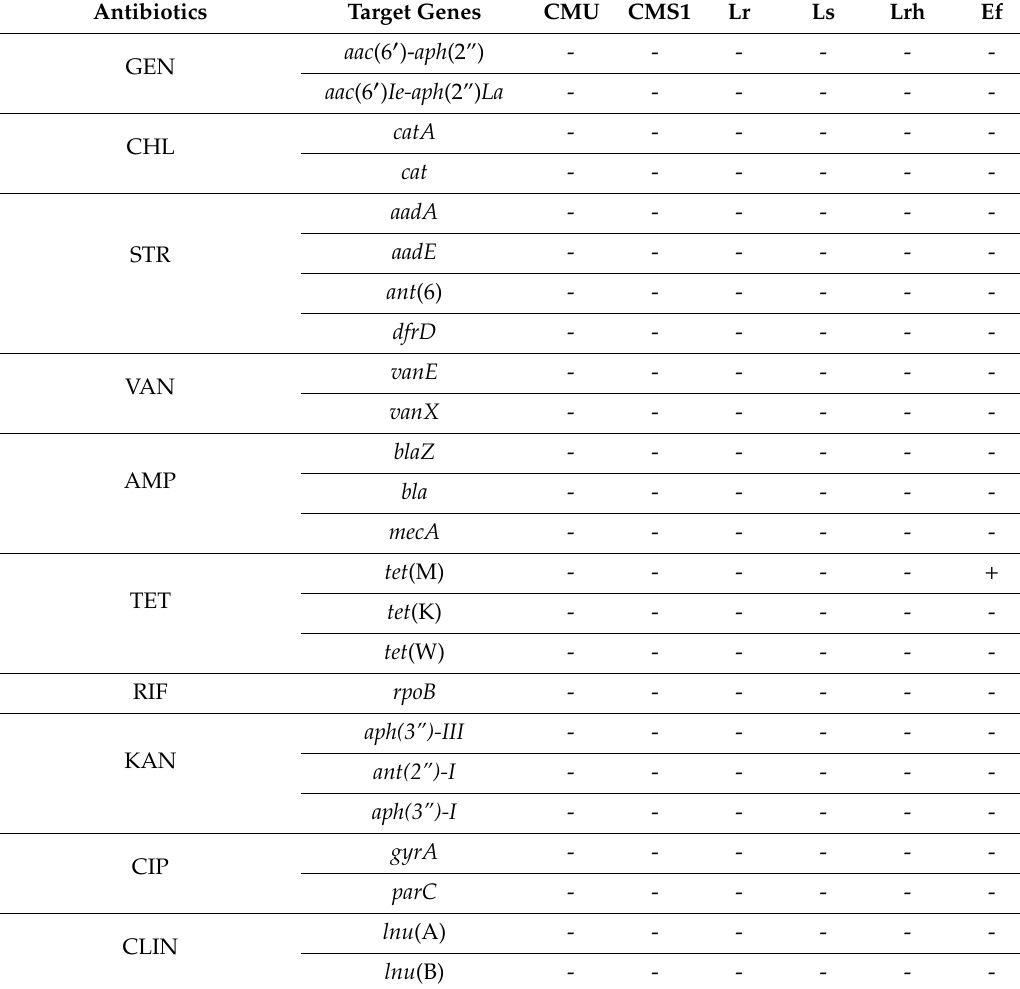
Table 2. Antibiotic resistance genes (ARGs) of the studied bacterial strains.